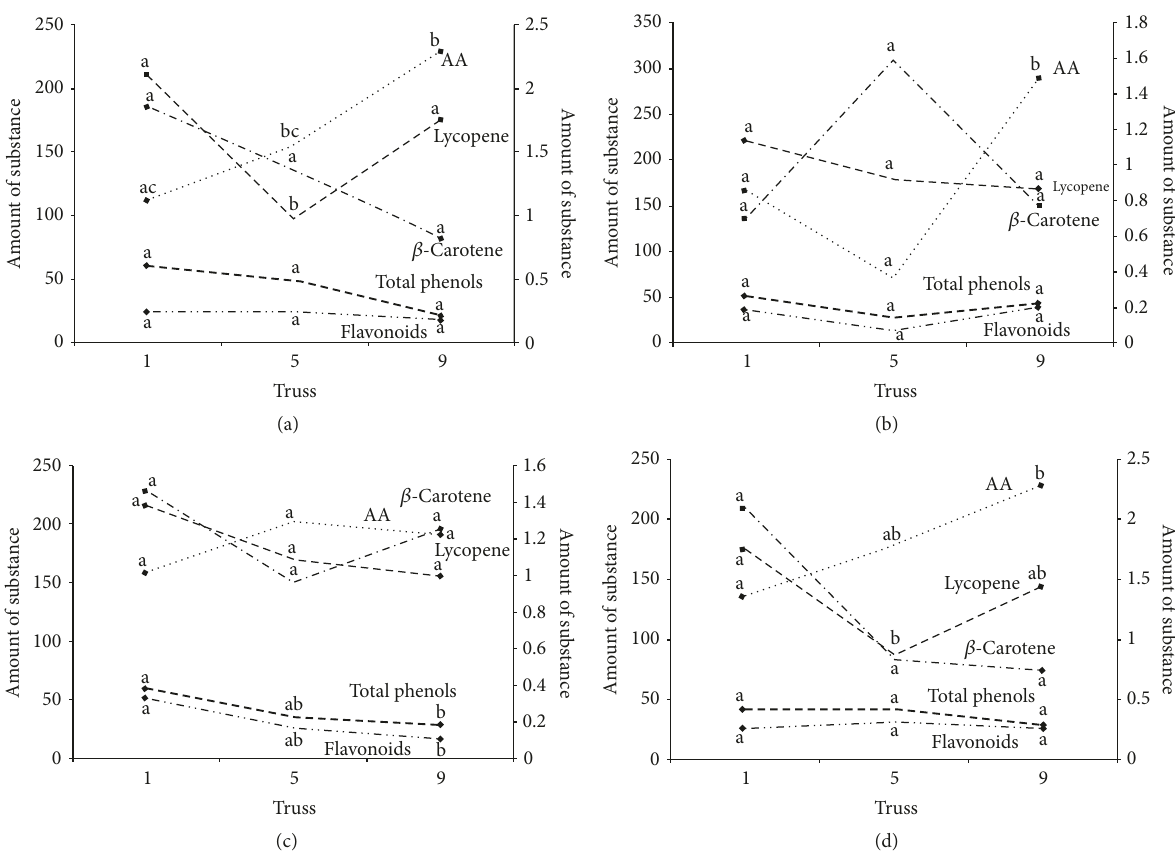
Figure 1: Behavior of bioactive compounds and antioxidant activity in three different trusses, and the effects of elicitor application on tomato plants. Each point is the average of three replicates. Different letters between rows indicate significant differences at 𝑃 ≤ 0.05. Units for lycopene: 100g mg −1 FW; 𝛽 -carotene: 100g mg −1 FW; phenols: 𝜇 g GAE g −1 FW; flavonoids: RE gmg −1 FW; antioxidant activity: 𝜇 M TEAC 100g −1 FW ((a) SA; (b) MeJ; (c) NO; (d) H 2 O 2 ).